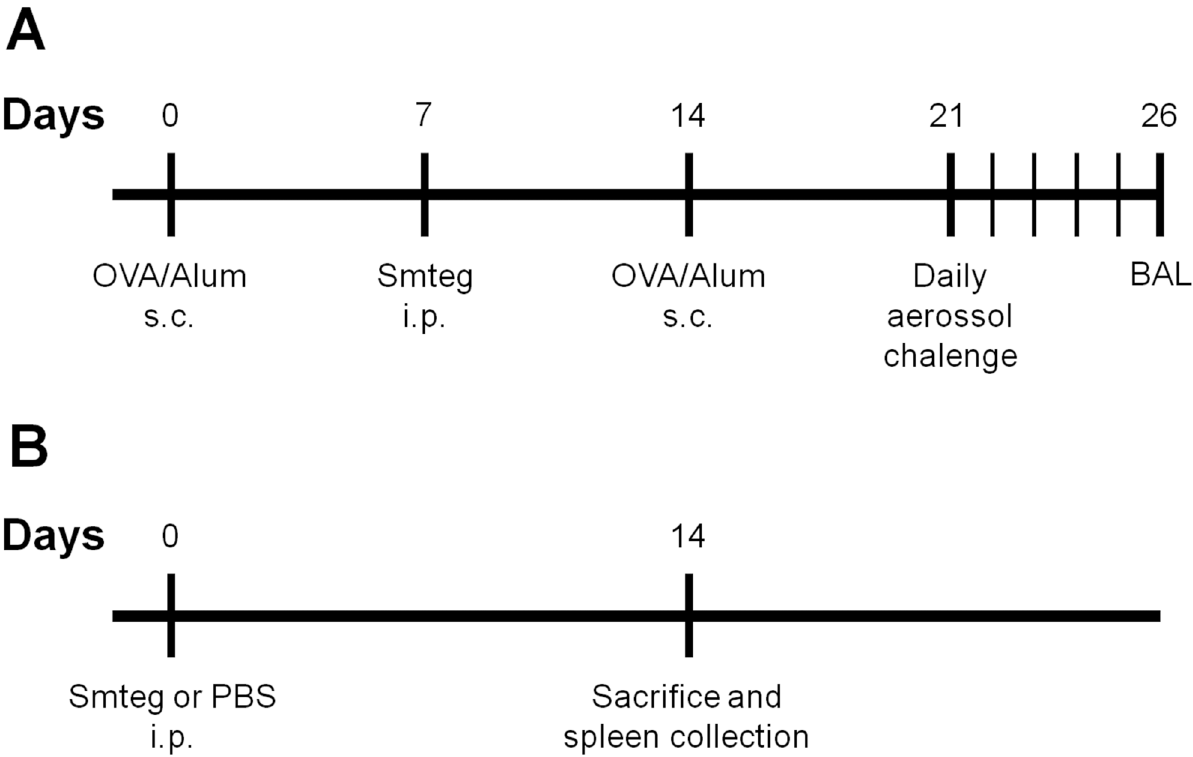
Fig 1. Induction of airway inflammation and inoculation of Smteg in murine model. ( A ) BALB/c mice were sensitized with OVA on days 0 and 14 and received Smteg on day 7. Mice were challenged with aerosol from days 21 to 25 and euthanized on day 26. ( B ) Mice received Smteg or PBS and were sacrificed after 14 days. s.c. – subcutaneous, i.p. – intraperitoneal, BAL- bronchoalveolar